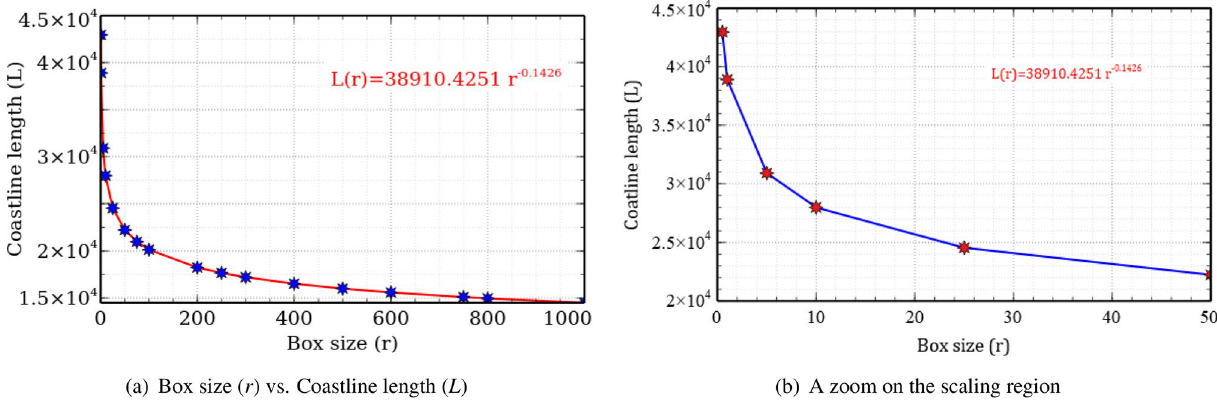
Figure 6. Power law for coastline length of Australia (created using Veusz software, version 3.2.1 available at https:// veusz. github. io/ downl of Australia as 1.143 which is in close agreement with the divider dimension 1.130 obtained by Richardson 35 ,